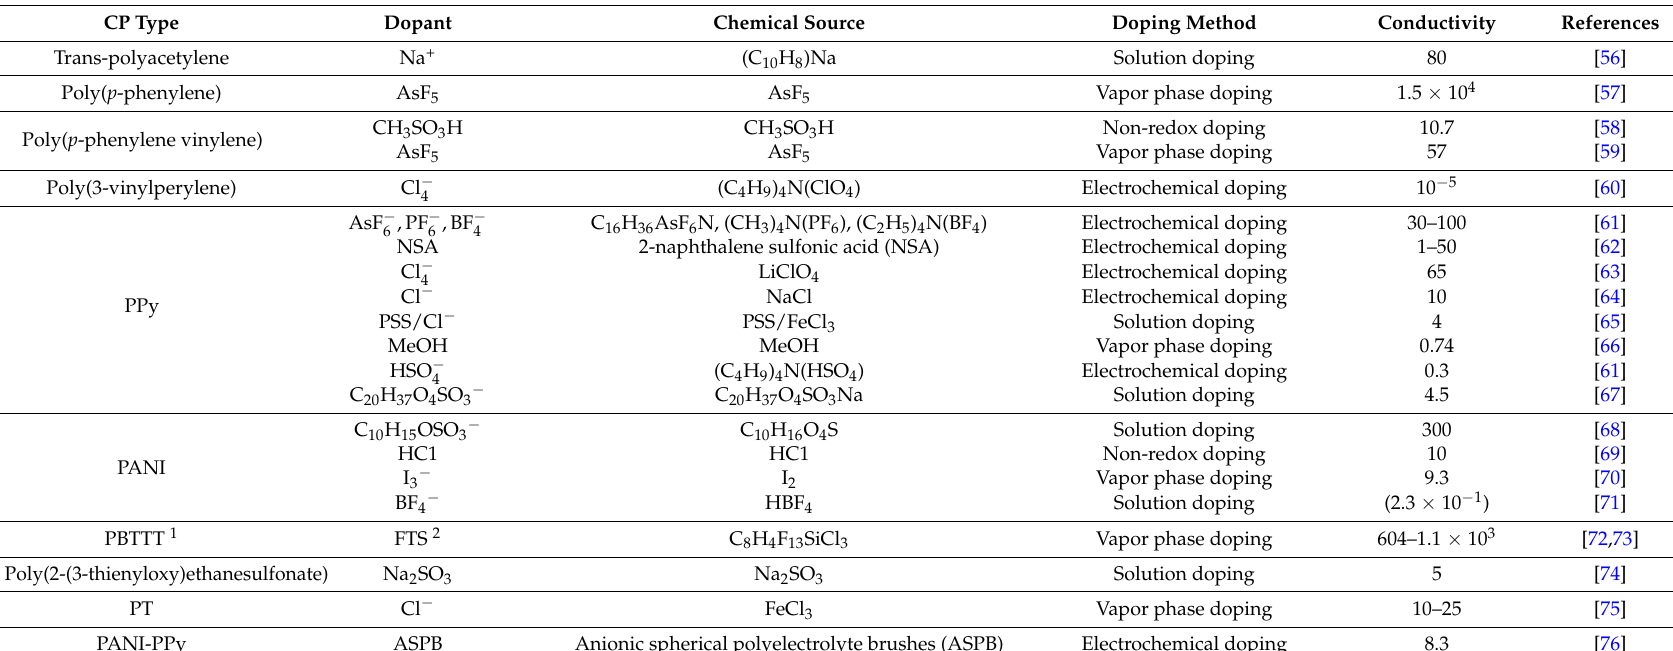
Table 2. Typical examples of dopants for CPs and the conductivities obtained